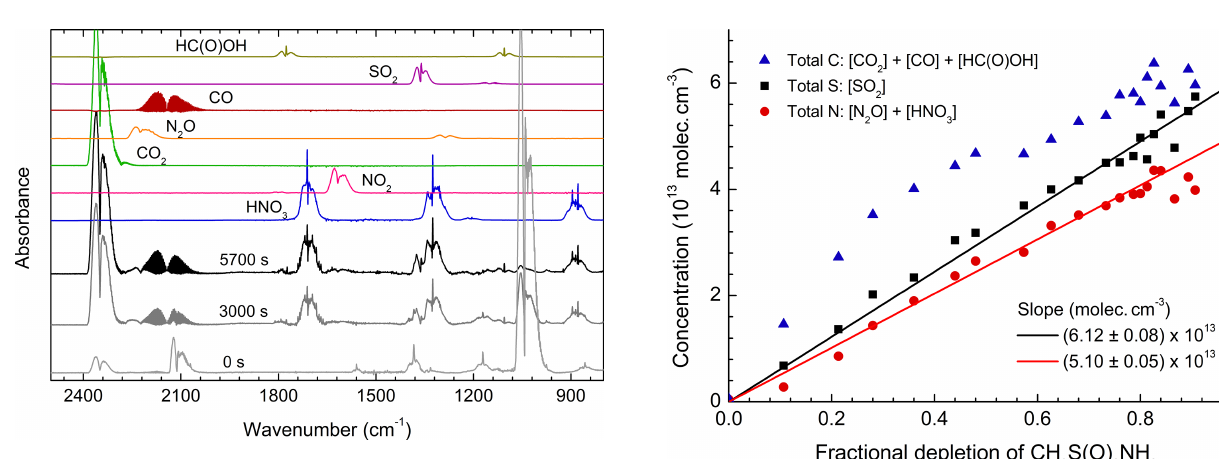
Figure 4. Infrared spectrum acquired prior to (0s) and after (3000 and 5700s) photolysis of a mixture of MSAM, O 3 , H 2 , and air. During irradiation, OH concentrations were ≈ 3 × 10 9 molec . cm − 3 . H 2 O-absorption features have been subtracted from the spec- tra. Reference spectrum of HNO 3 , NO 2 , CO 2 , N 2 O, CO, SO 2 , and HC ( O ) OH recorded under the same experimental conditions (700Torr and 298K) are also shown.